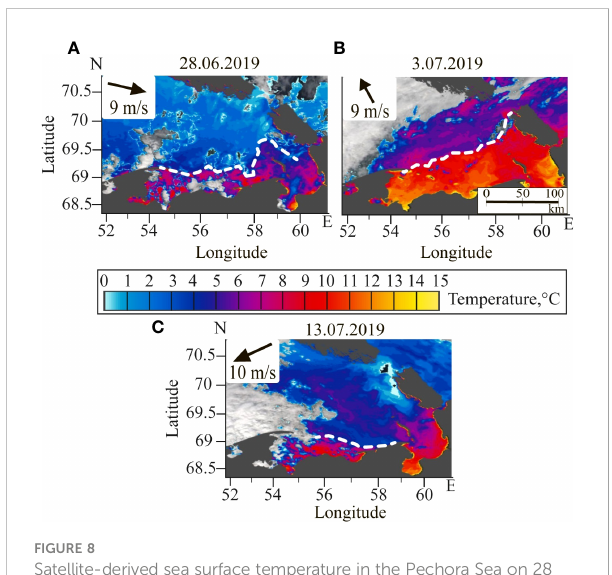
FIGURE 8 Satellite-derived sea surface temperature in the Pechora Sea on 28 June (A) , 3 July (B) , 13 July (C) 2019 acquired by MODIS Terra/Aqua. Locations of the Pechora plume border is indicated by white dashed lines. Dark grey color indicates land, white color indicates cloud coverage of the study area. Wind directions and velocities averaged during two days preceding the satellite image are shown in the insets.